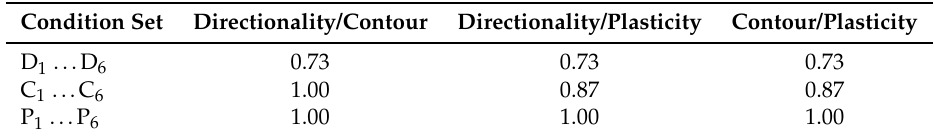
Table 3. Kendall rank correlation of median ratings in Directionality/Contour/Plasticity for each condition